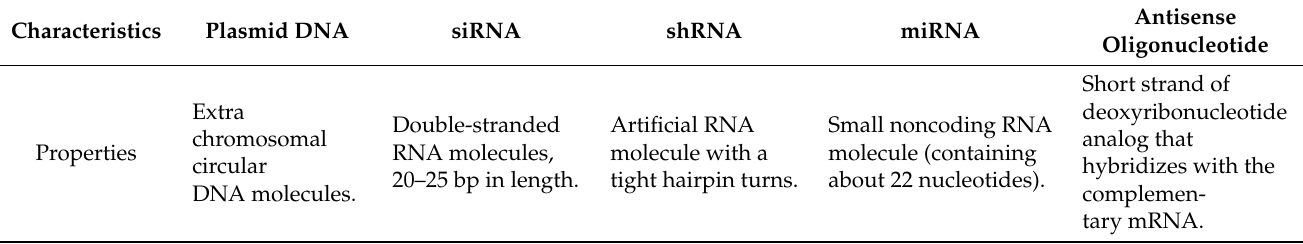
Table 1. Nucleic-acid-based